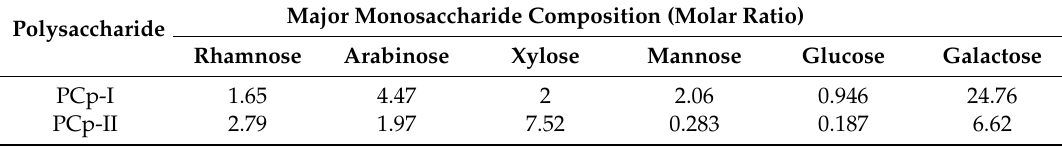
Table 3. Monosaccharide compositions of PCp-Iand PCp-II.